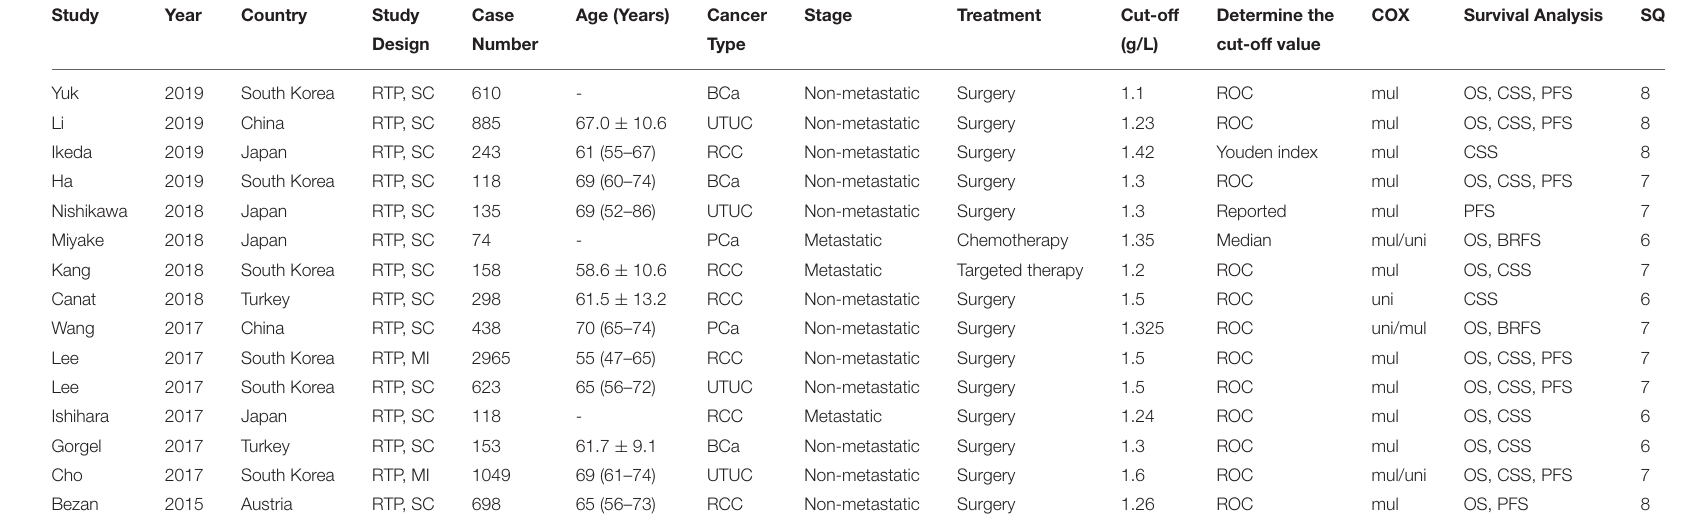
TABLE 1 | Features of included